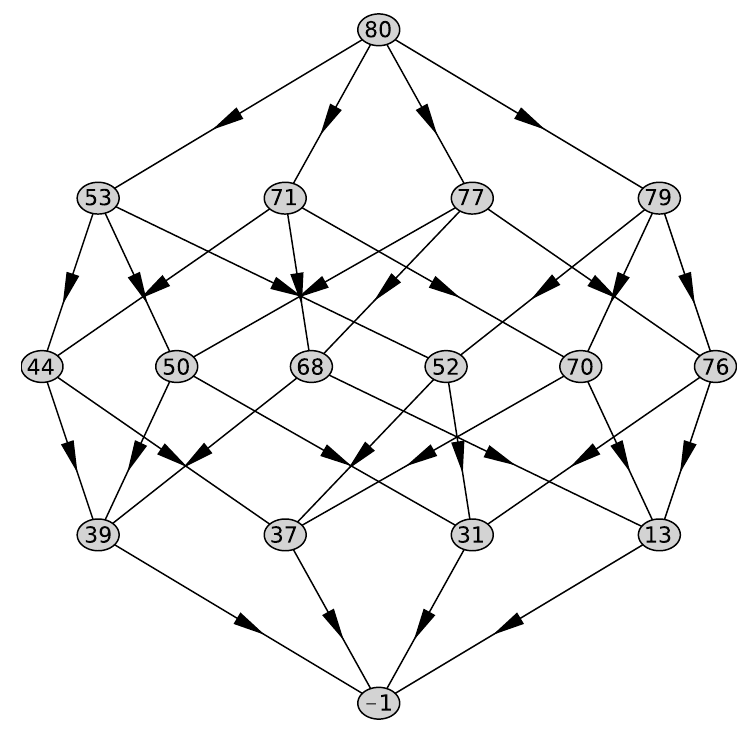
Figure 6. Graph of the polyhedron Γ ( E 2 S ) of Equation